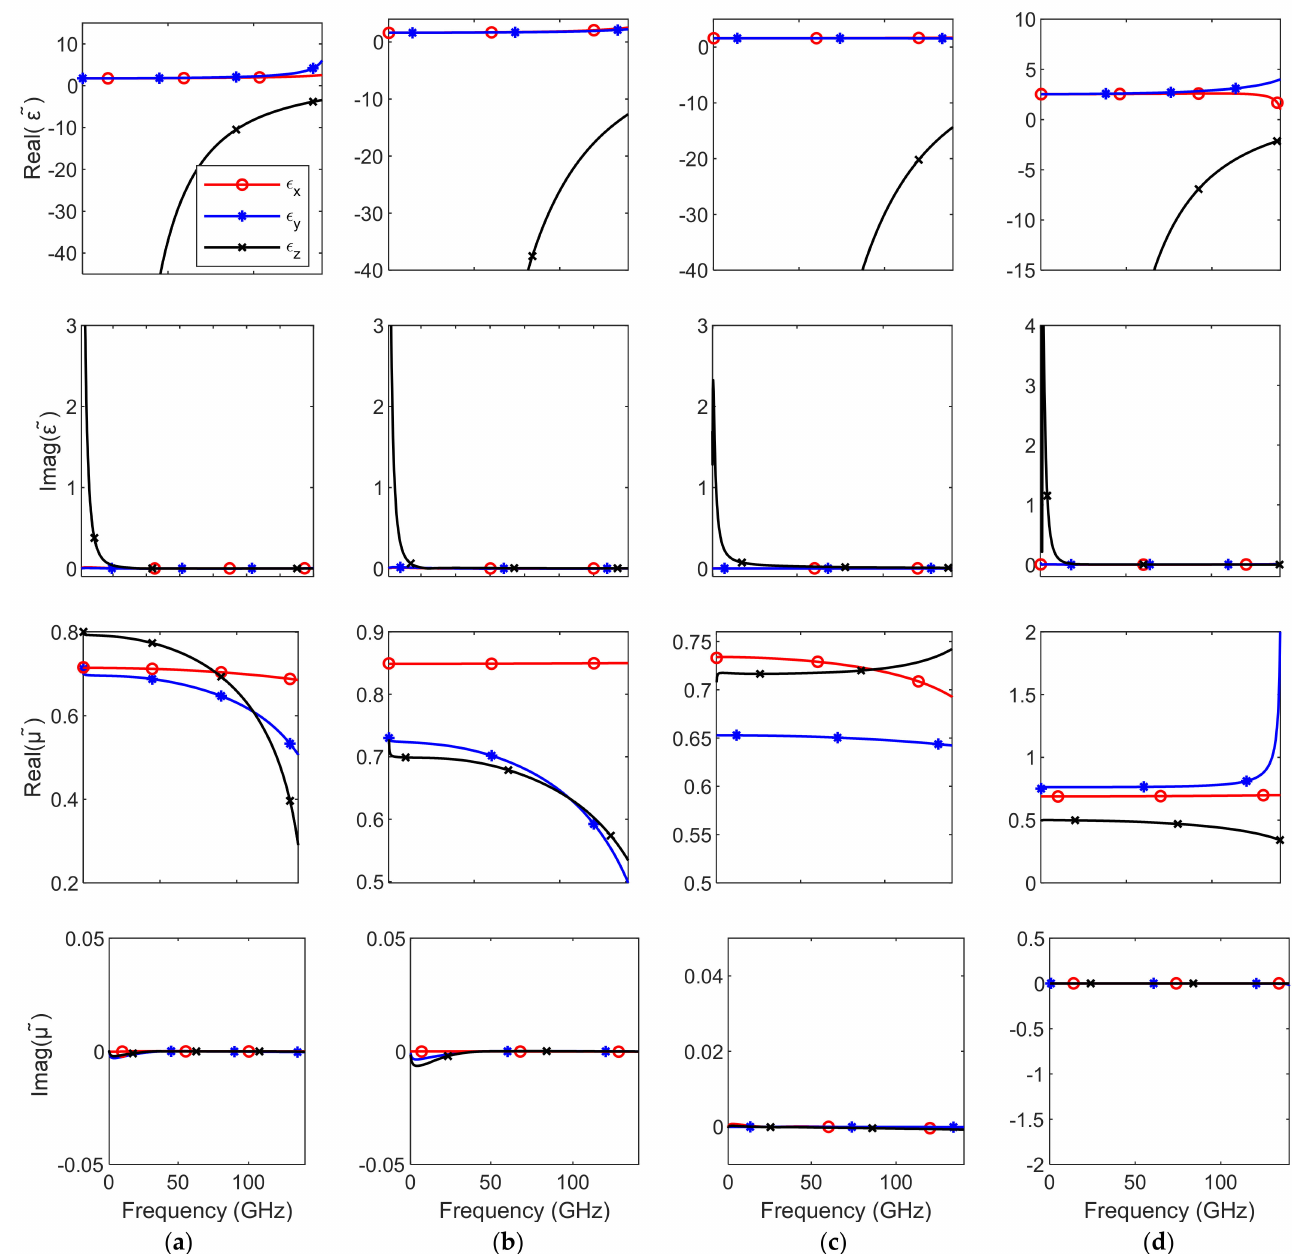
Figure 4. The extracted tensorial ˜ ε and ˜ µ of the unit cells A , B , C and D . ( a ) Unit cell A , ( b ) unit cell B , ( c ) unit cell C , and ( d ) unit cell D